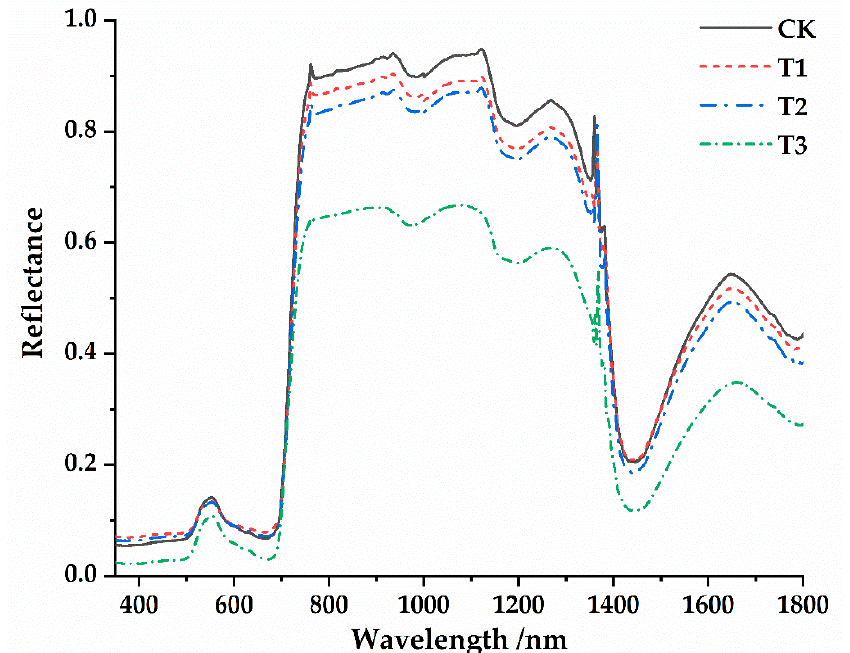
Figure 4. Spectral reflectance of healthy Osmanthus fragrans leaves and spectral reflectance of Osmanthus fragrans with different parasitic degrees.